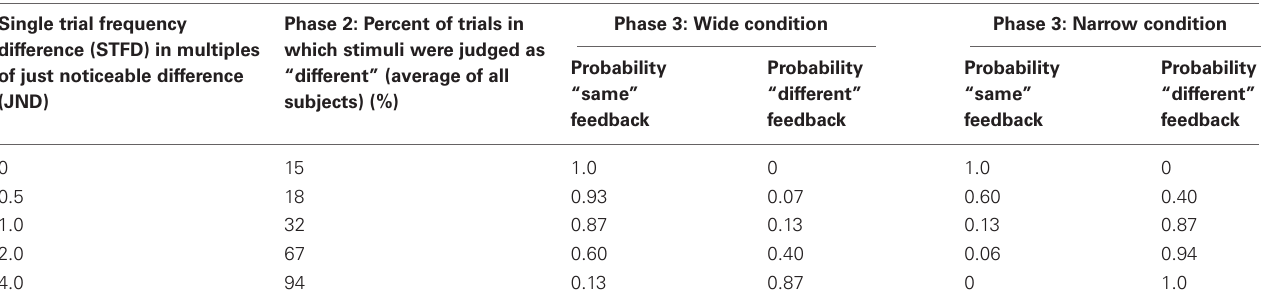
Table 1 | Feedback parameters for subjects in the wide and narrow condition. Single trial